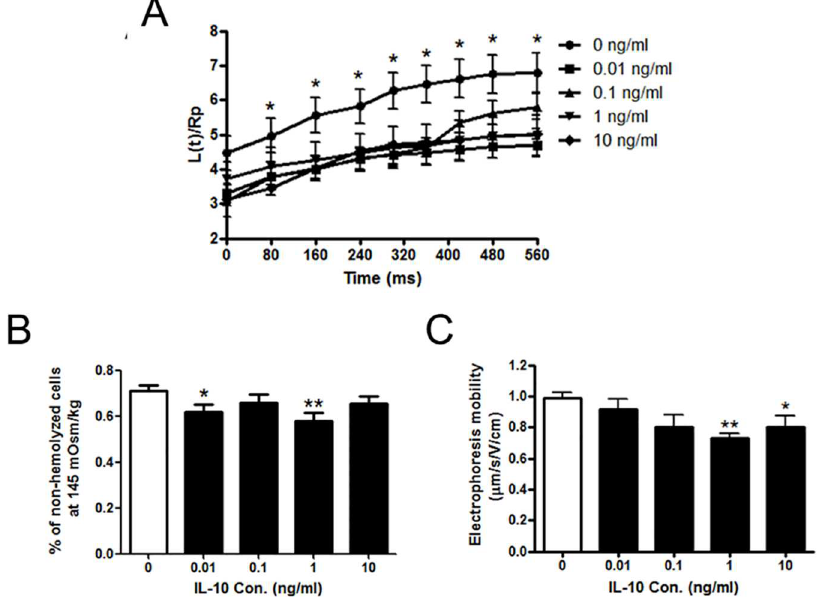
Fig 1. The effects of IL-10 on the biophysical properties of mDCs. (A) The deformation of mDCs treated by IL-10 measuredby micropipette aspiration. The ratios betweenthe lengthof cell tongue aspirated into the micropipette, L(t), and the radius of pipette, Rp, were plotted againstthe time of aspiration.(B) The percentage of non-hemolyzed cells at osmotic pressureof 145mOsm/kg. (C) Electrophoretic mobilitiesof mDCs treated by IL-10. Comparedwith control group: * p < 0.05, ** p <